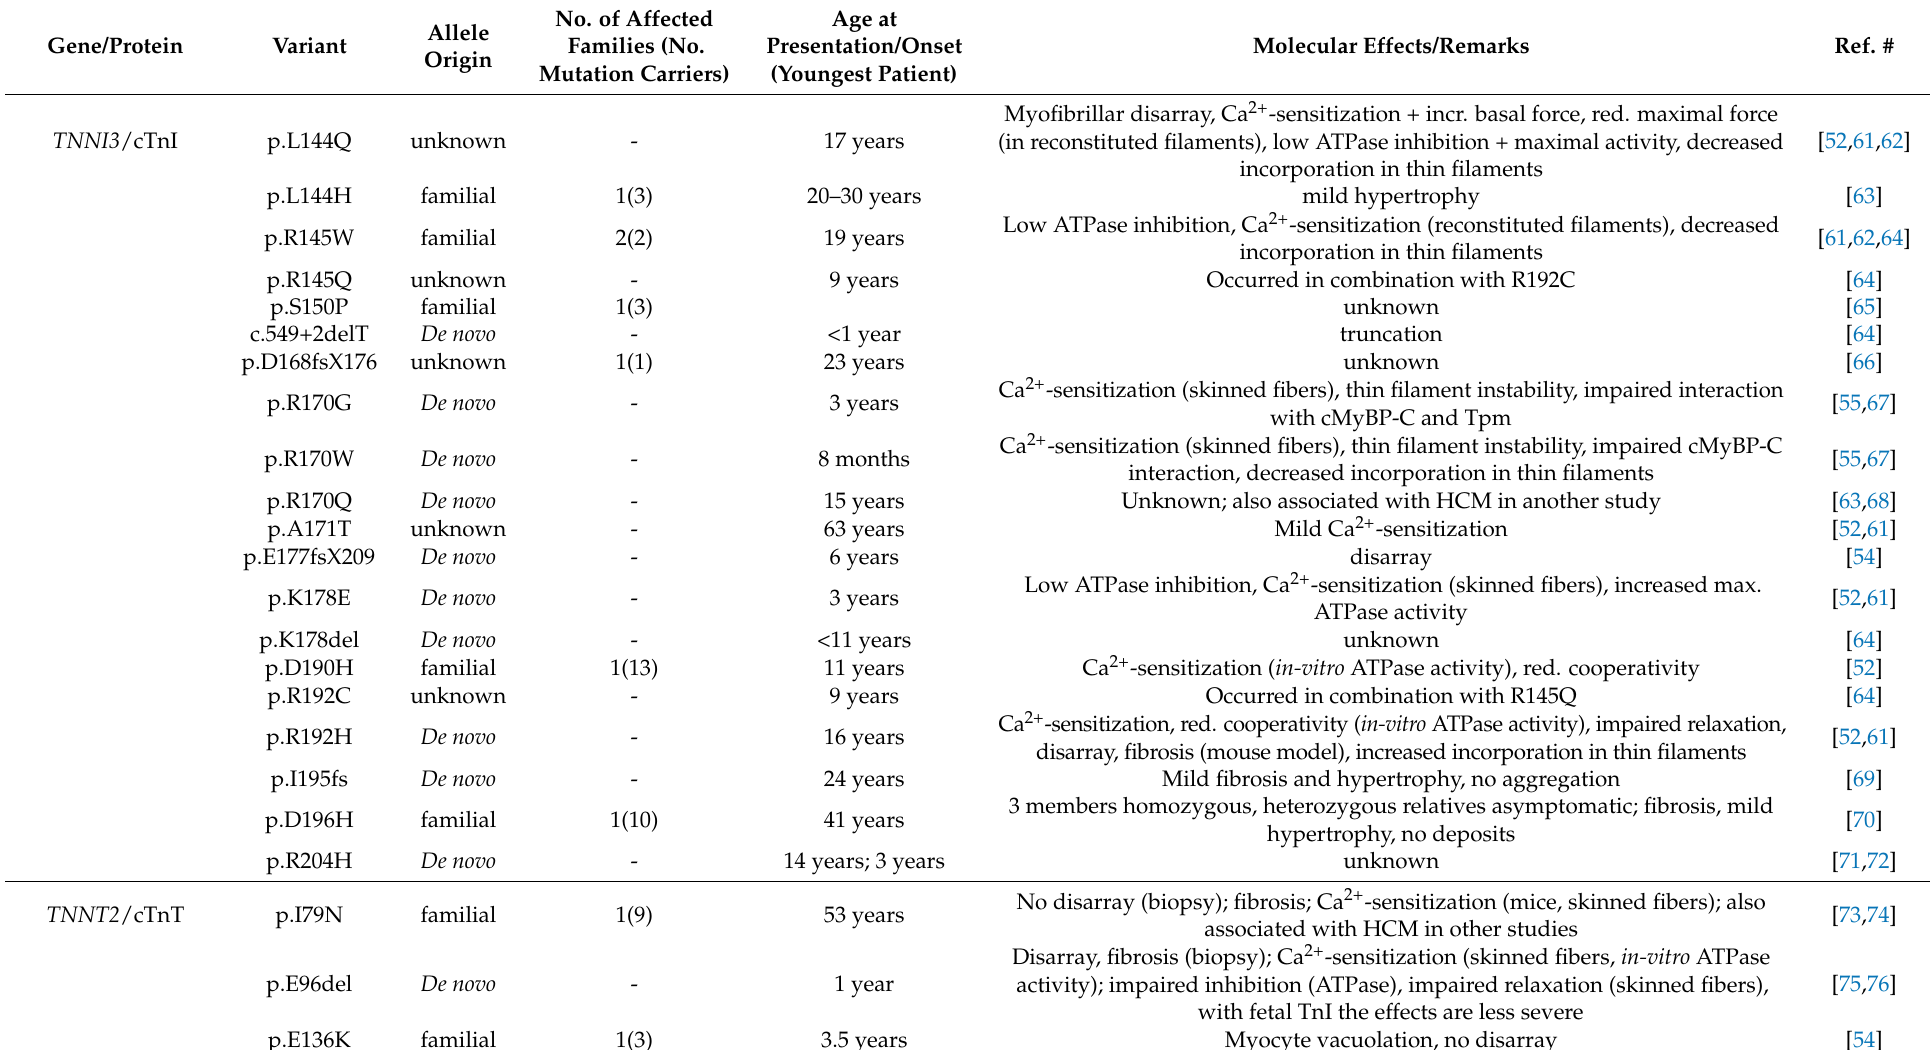
Table 1. Overview of mutations in sarcomeric and non-sarcomeric proteins associated with restrictive